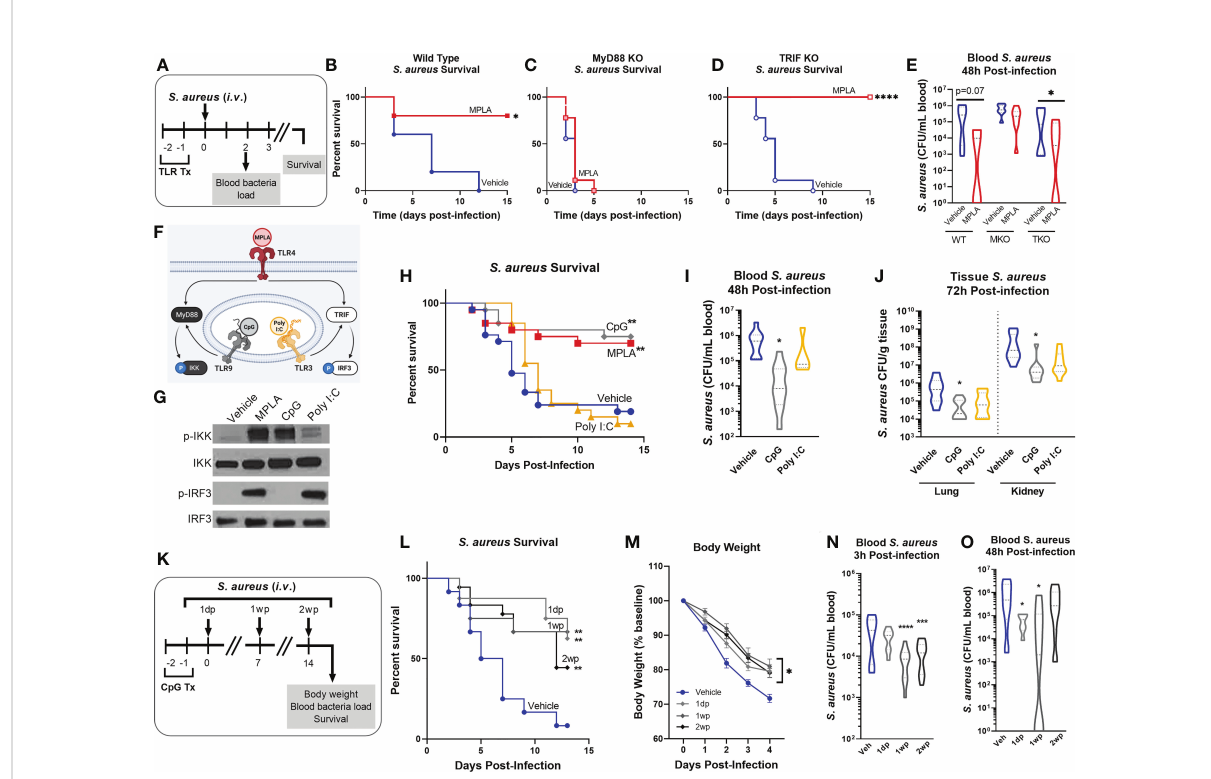
FIGURE 1 MYD88-activating CpG, but not TRIF-activating Poly I:C, confers resistance to S. aureus infection. (A) Mice were injected with TLR agonists (20 µg i.v. ), or vehicle (Lactated Ringers) for two consecutive days prior to systemic challenge with S. aureus ( i.v. ). (B-D) Wild type (B) , MyD88-KO (C) , and TRIF-KO mice (D) were challenged with S. aureus and survival was monitored for 15 days (n=5-9/group). (E) Bacteremia was assessed 48h after infection. (F) Schematic of TLR agonist pathway speci fi city and downstream signaling. (G) Pathway speci fi city of MPLA, CpG, and Poly I:C were determined by Western blotting of protein isolated from wild type BMDMs treated for 24h with TLR agonists compared to unstimulated negative controls. (H) Survival was monitored for 15 days post- S. aureus inoculation (n = 20-21/group). (I) Bacteremia was assessed 48h after infection (n = 5-10). (J) Tissue bacterial load (CFU/gram) of lung and kidney was quanti fi ed at 72h post-infection (n = 8-10/group). (K) Mice were infected with 10 8 CFU S. aureus ( i.v. ) 1 day-post (1dp), 1 week-post (1wp) or 2 weeks-post (2wp) CpG treatment alongside vehicle-treated controls. (L) Survival was monitored for 15 days post-infection (n = 10-18/group). (M) Body weights were measured at baseline and after infection. (N, O) Bacteremia was assessed at 3h (N) and 48h (O) post-infection. Mean ± SEM are shown for body weight (M) . *p < 0.05, **p < 0.01, ***p < 0.001, ****p < 0.0001 by a log-rank Mantel – Cox test for Kaplan – Meier survival plots or otherwise determined by ANOVA followed by Dunnett ’ s post-hoc multiple comparison